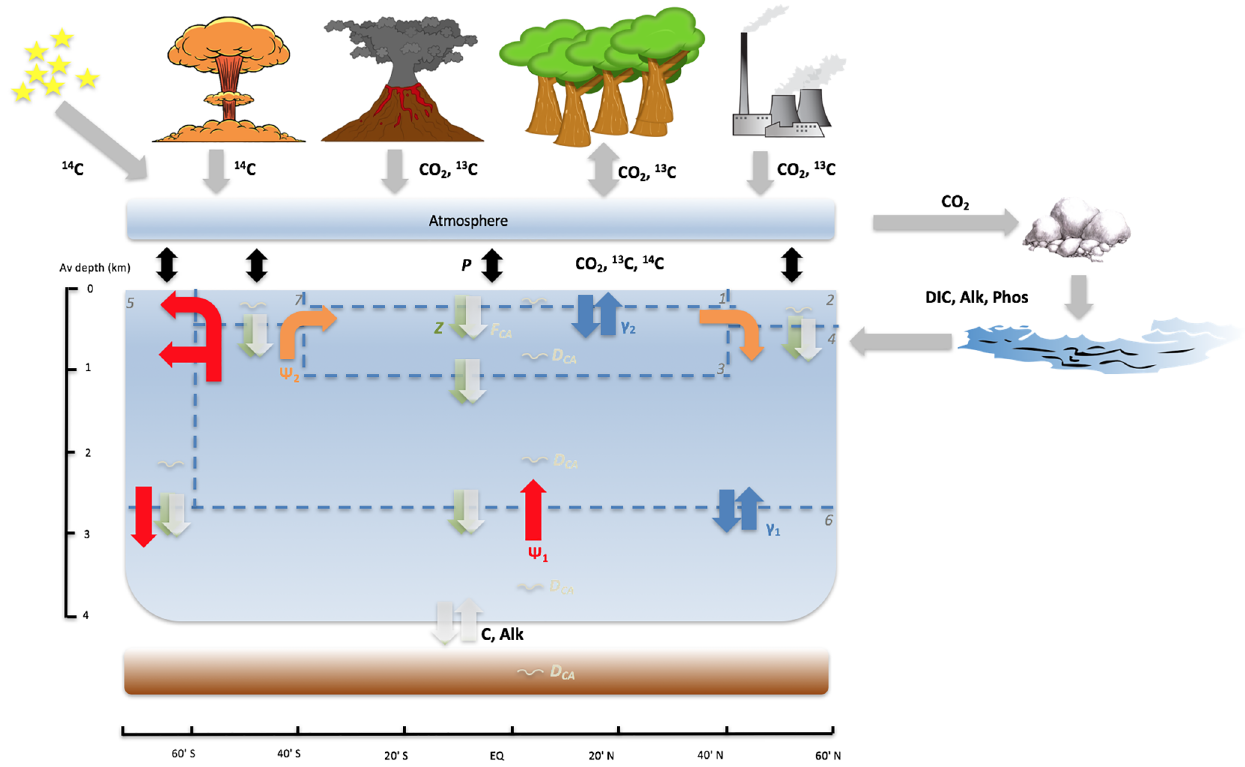
Figure 1. SCP-M: configured as a seven-box ocean model plus atmosphere with marine sediments, continents and the terrestrial biosphere. The exchange of elemental concentrations, e.g. C i (i = 1 , 7 ) , occurs due to fluxes between boxes. (cid:57) 1 (red arrows) is global overturning circulation (GOC), (cid:57) 2 (orange arrows) is Atlantic meridional overturning circulation (AMOC), γ 1 (blue arrows between boxes 4 and 6) is deep–abyssal mixing, γ 2 (blue arrows between boxes 1 and 3) is low-latitude thermohaline mixing, Z (green downward arrows) is the biolog- ical pump, F CA (white downward arrows) is the carbonate pump, D CA (white squiggles) is carbonate dissolution and P (black, bidirectional arrows) is the air–sea gas exchange. Box 1: low-latitude–tropical surface ocean; box 2: northern surface ocean; box 3: intermediate ocean; box 4: deep ocean; box 5: Southern Ocean; box 6: abyssal ocean; box 7: subpolar southern surface